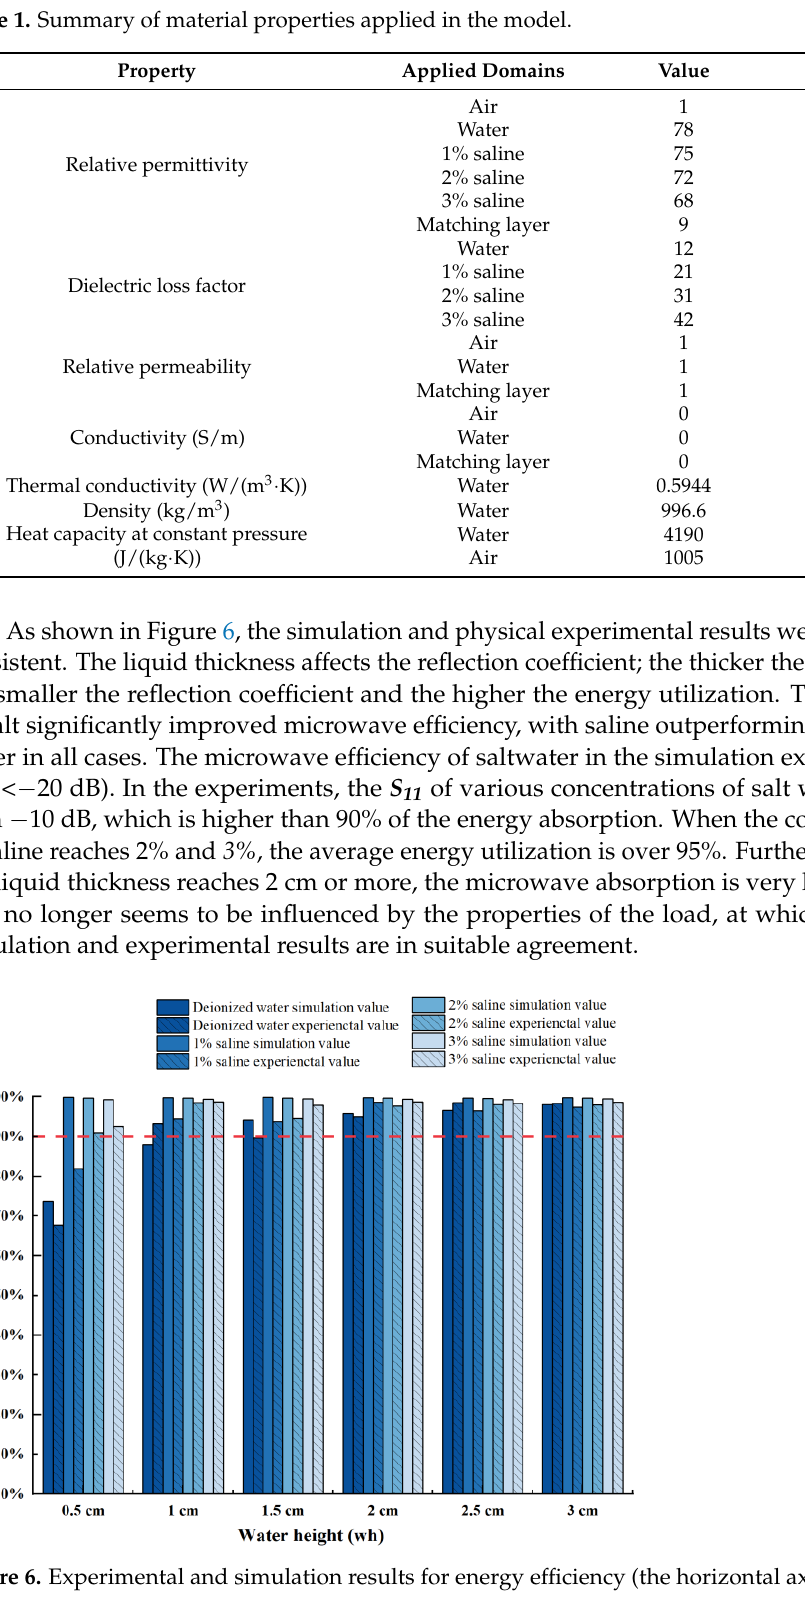
Figure 6. Experimental and simulation results for energy efficiency (the horizontal axis represents the different liquid layer thicknesses. The darkest blue bar indicates water, then the colors from dark to light indicate 1% concentration saline, 2% concentration saline, and 3% concentration saline, respectively. Bars with slashes indicate physical experimental results, and bars without slashes include simulation results).